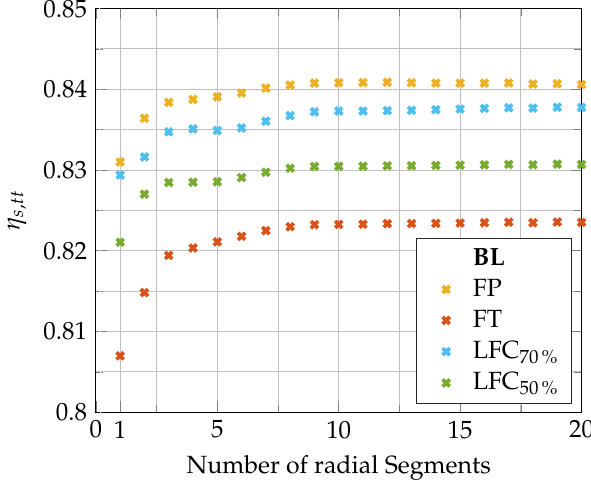
Figure 10. Convergence study for number of radial segments.